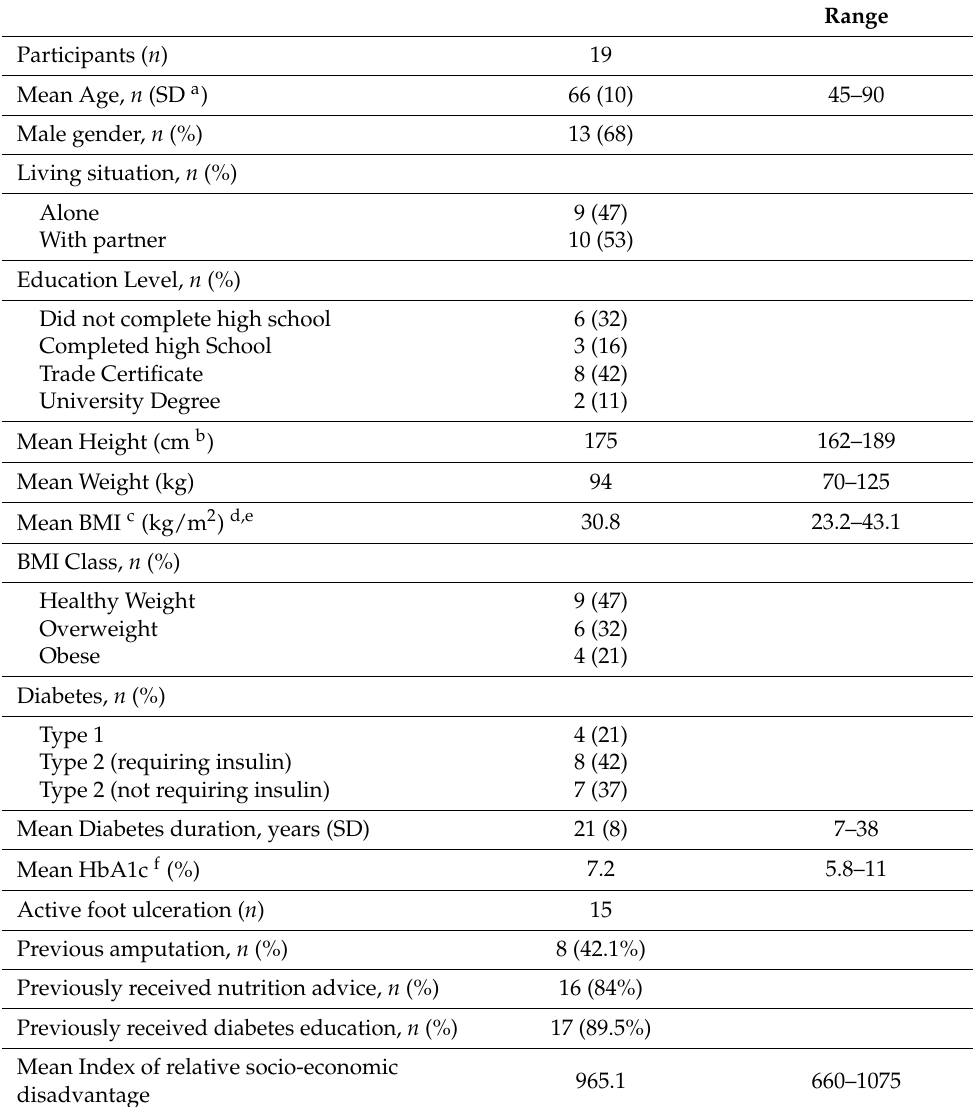
Table 1. Descriptive characteristics of nineteen diabetes-related foot ulceration patients participating in semi-structured